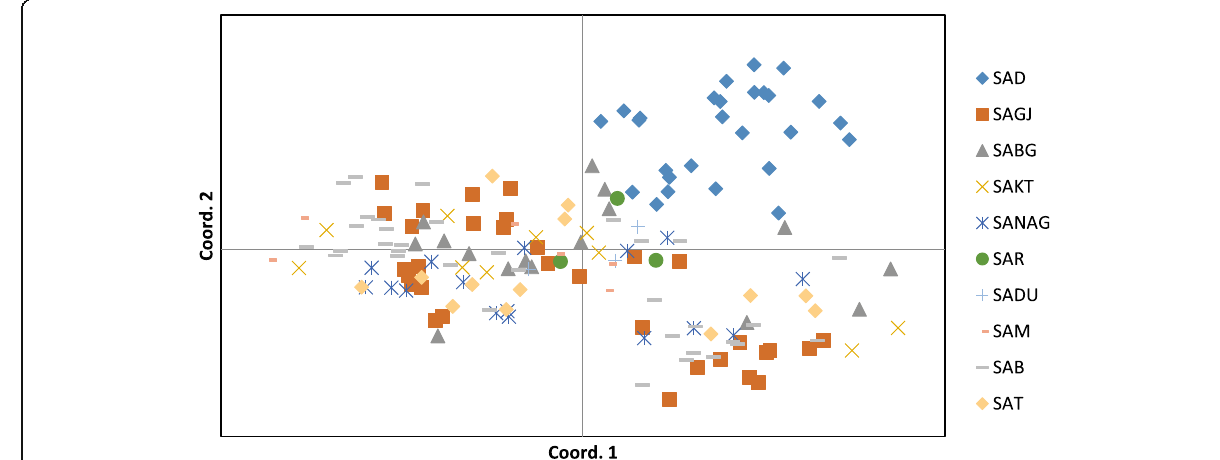
Fig. 3 Principal coordinate analysis (PCoA) plot of RAPD profiles of the ten S. asoca